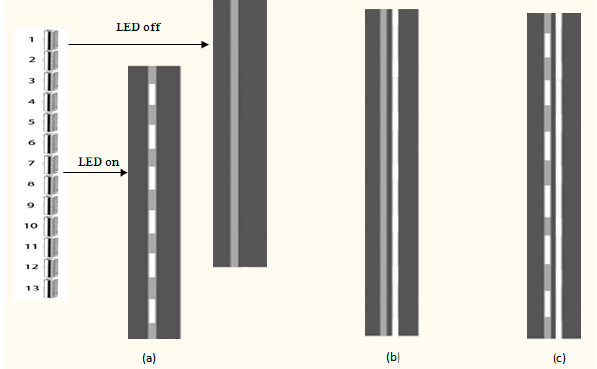
Figure 13. Schematic diagram of variable lane line: ( a ) Working principle and the effect of the variable lane line; ( b ) Non-working state of the combination of variable lane line and conventional lane line; ( c ) Working state of combination of variable lane line and conventional lane line.